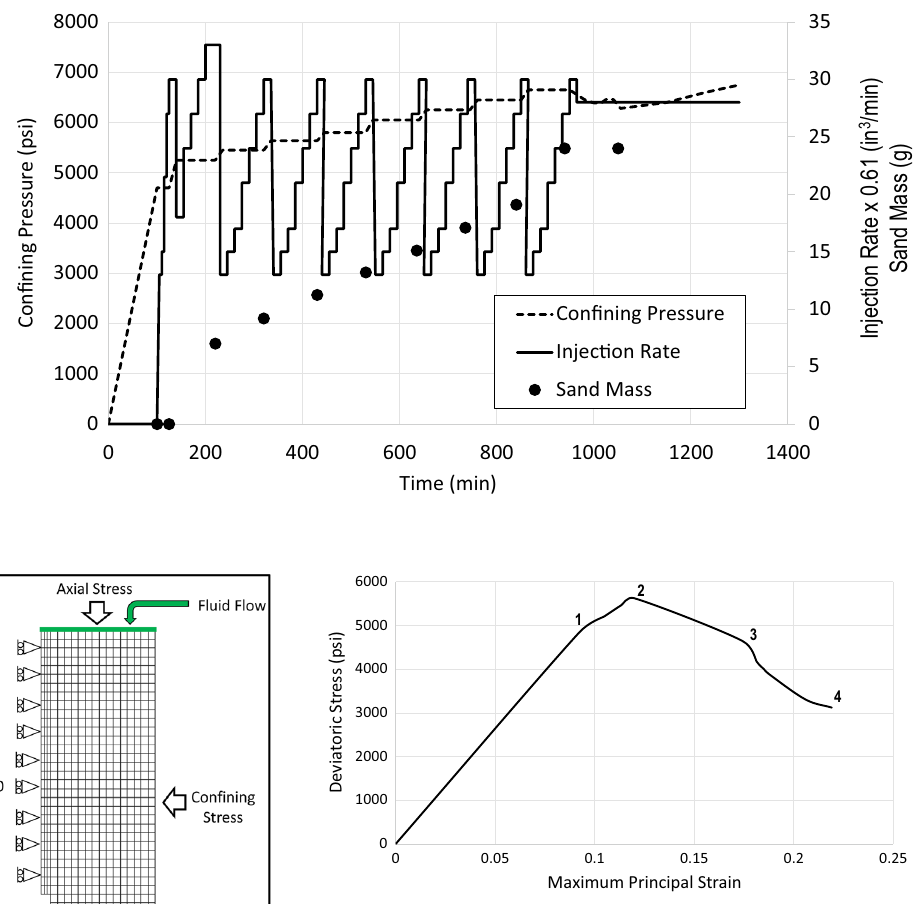
Fig. 14 Deviatoric stress versus maximum principal stress behavior at the perforation tip